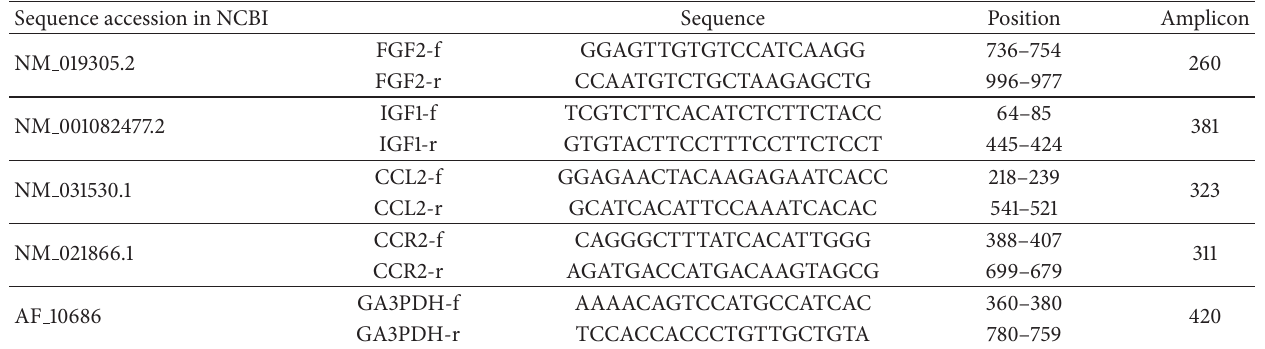
Table 1: List of primers to amplify chemokine and growth